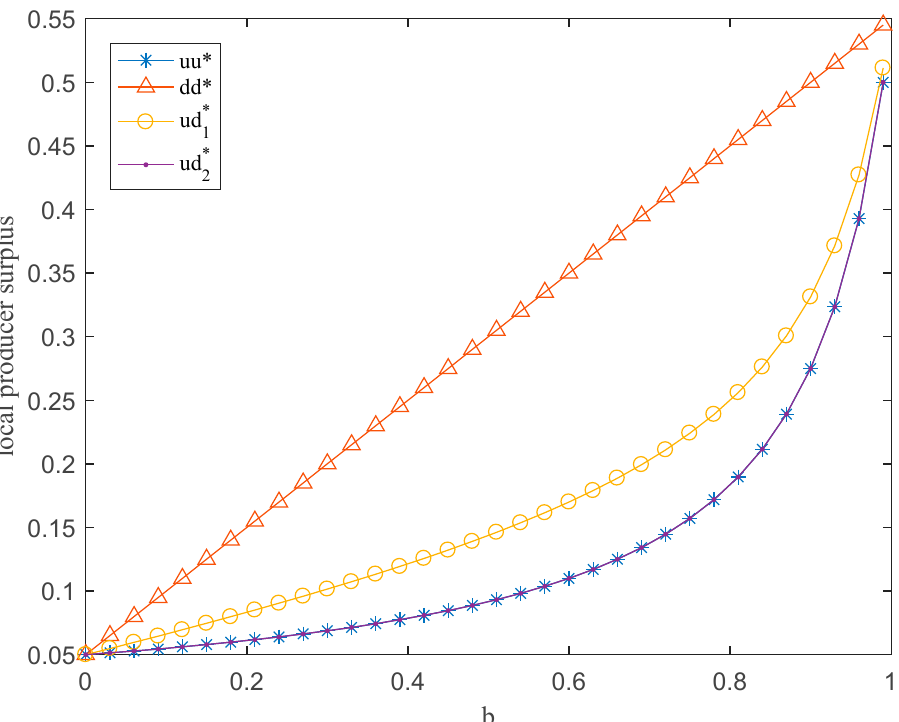
Figure 6. The local producer surplus under different situations.